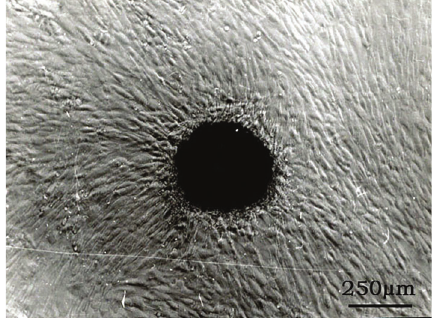
Figure 3. Fibroblasts induced with 40 m g/mL fi bronectin had decentered nucleus and distinct particles in cytoplasm at 5 days. HE staining, (cid:1) 200.